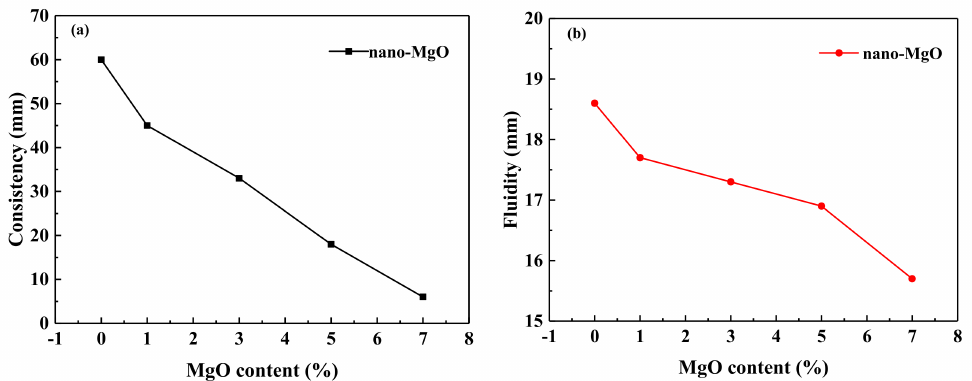
Figure 5. Influence of MgO on the consistency ( a ) and fluidity ( b ) of cement